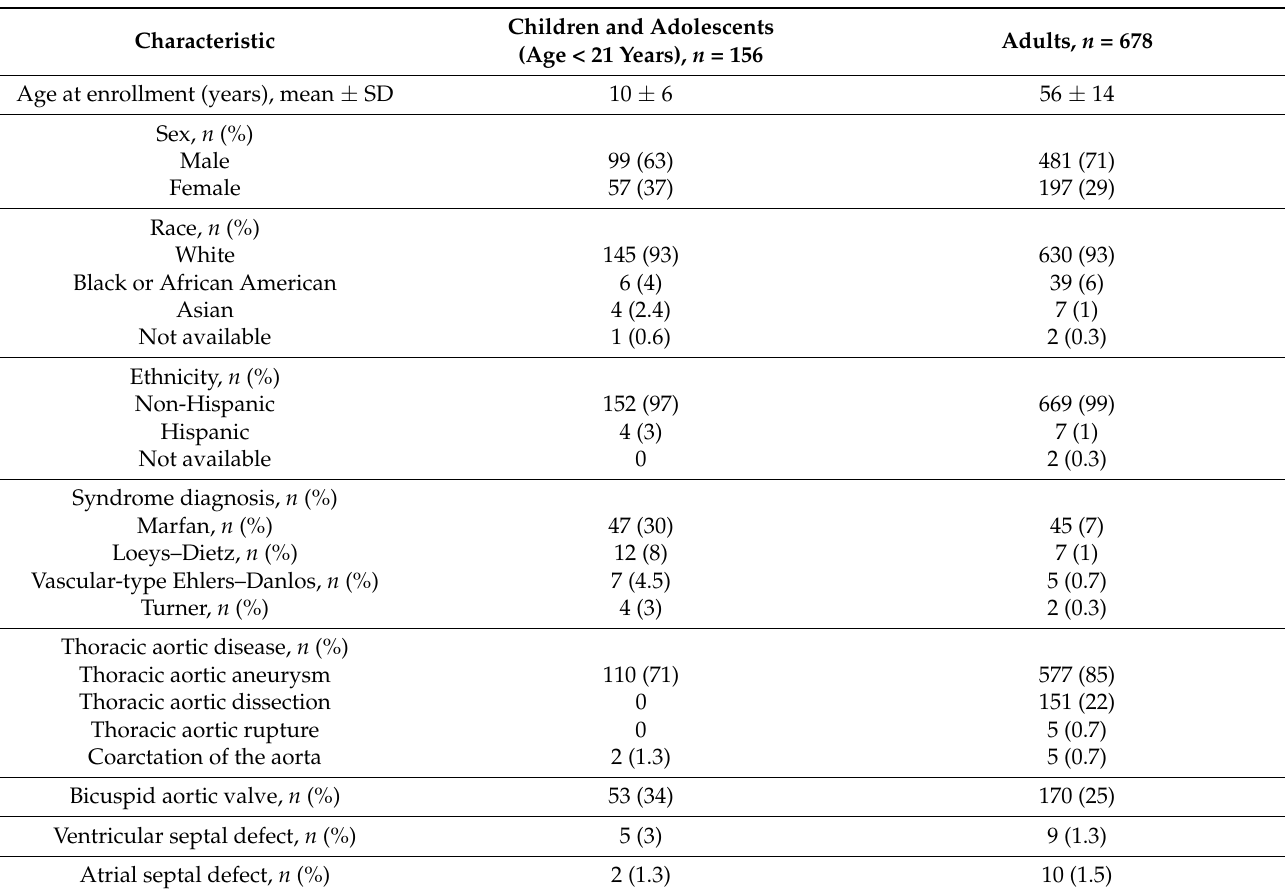
Table 4. Characteristics of the affected participants enrolled into the CHAR study.